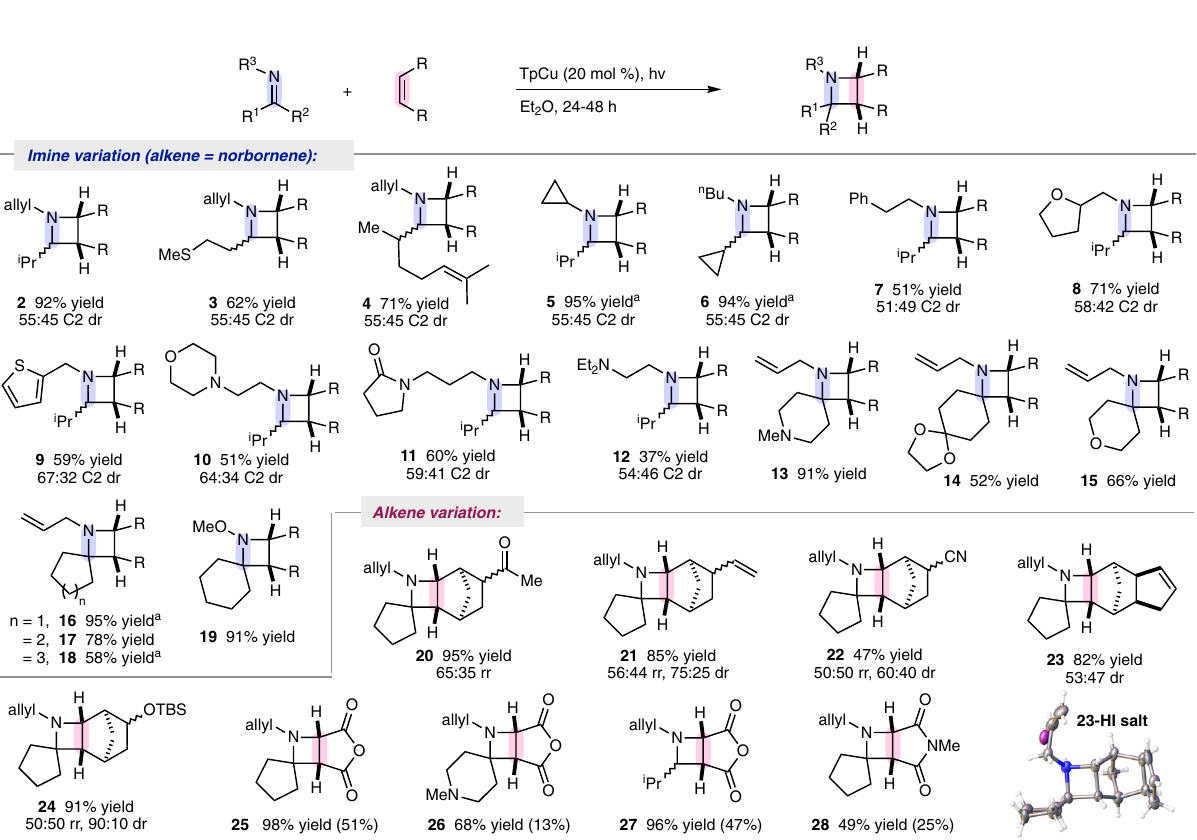
Fig. 2 2 + 2 Imine-ole fi n photocycloaddition reaction scope. Summary of imine and alkene substrate variation. All reactions carried out with 1 equiv alkene, 1.1 equiv imine, 20 mol % TpCu, in diethyl ether (0.15 M) and irradiated with a 100 W Hg lamp in borosilicate tubes; all yields are of isolated material following puri fi cation via basic alumina chromatography and diastereomeric ratios were determined via gas chromatography of crude reaction mixtures; all products detected as >95:5 exo : endo diastereomers. Yield in parentheses obtained in the absence of TpCu. a 3 equiv of imine